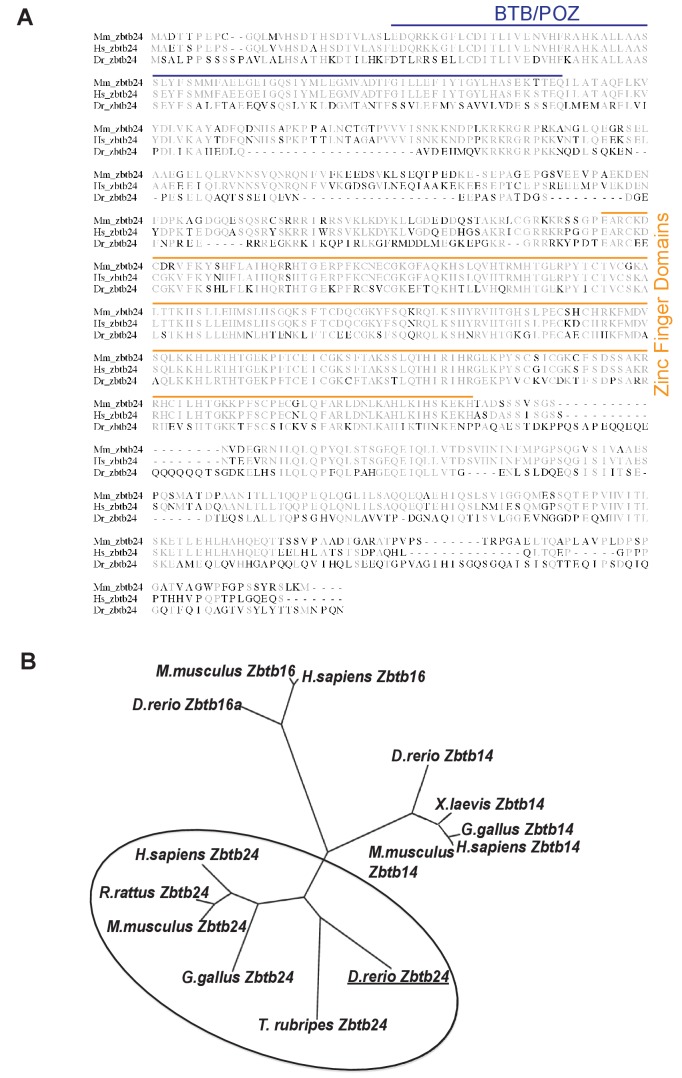
Zbtb24 conservation in vertebrate species.